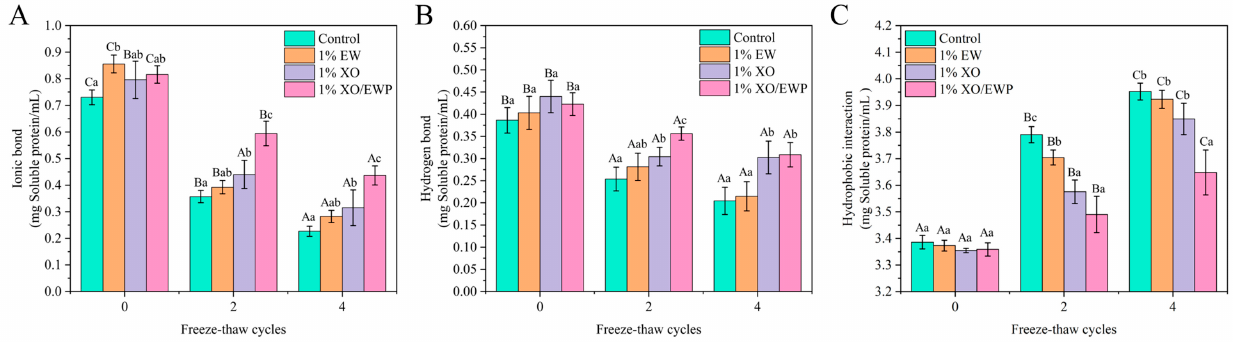
Fig. 5 Changes of ionic bond (A), hydrogen bond (B), and hydrophobic interaction (C) in the heat-induced gel of Culter alburnus myofibrillar protein added with EW, XO or XO/EW during freeze-thaw cycles (mean±SD, n=3). The control group (Control) was not added with EW, XO or XO/EW. Capital letters indicate a significant difference (P < 0.05) between different freeze-thaw cycles within the same treatment group. Lowercase letters indicate a significant difference (P < 0.05) between different treatment groups in the same freeze-thaw cycle.